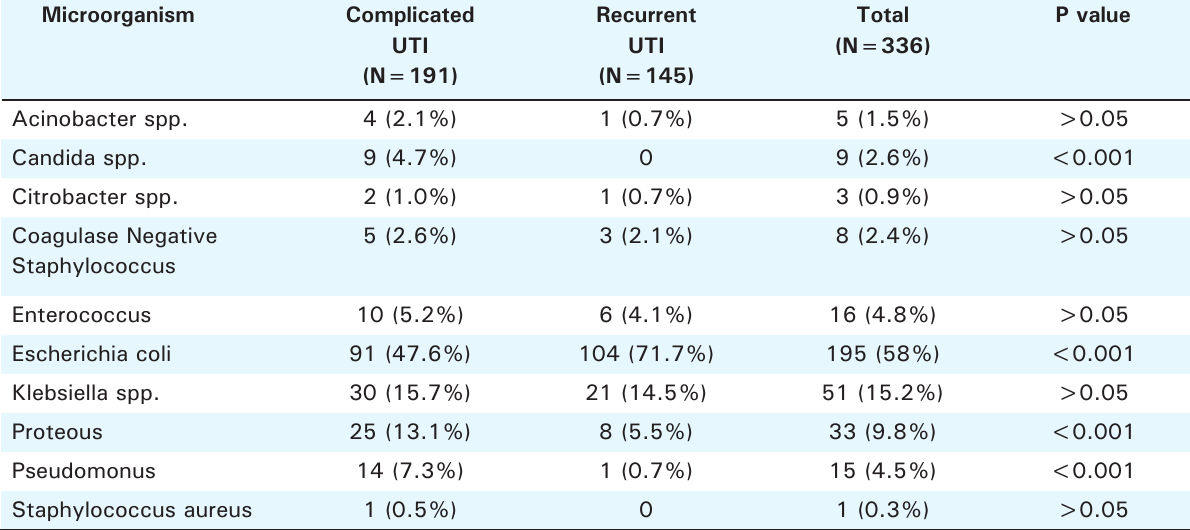
table 4. Prevalence of microorganisms in urine cultures Microorganism